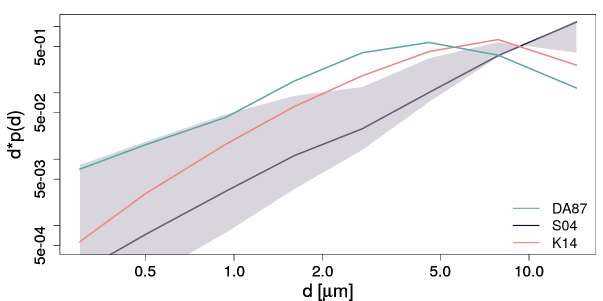
Figure 2. Normalized particle-size distributions (PSDs) based on D’Almeida (1987) (DA87, turquoise), Shao (2004) (S04, gray), and Kok (2011a) (as in K14, coral). The DA87 and K14 PSDs are in- variant, while the S04 PSD varies in time and space. Shown for the latter are the PSDs corresponding to the 50th percentile (me- dian; solid gray line) of the emission-weighted average diameters per model grid cell of annually accumulated dust emissions, framed by the PSDs belonging to the 5th and 95th percentiles (gray shad- ing). The S04 PSDs were obtained from the S04 experiment pre- sented in Sect.